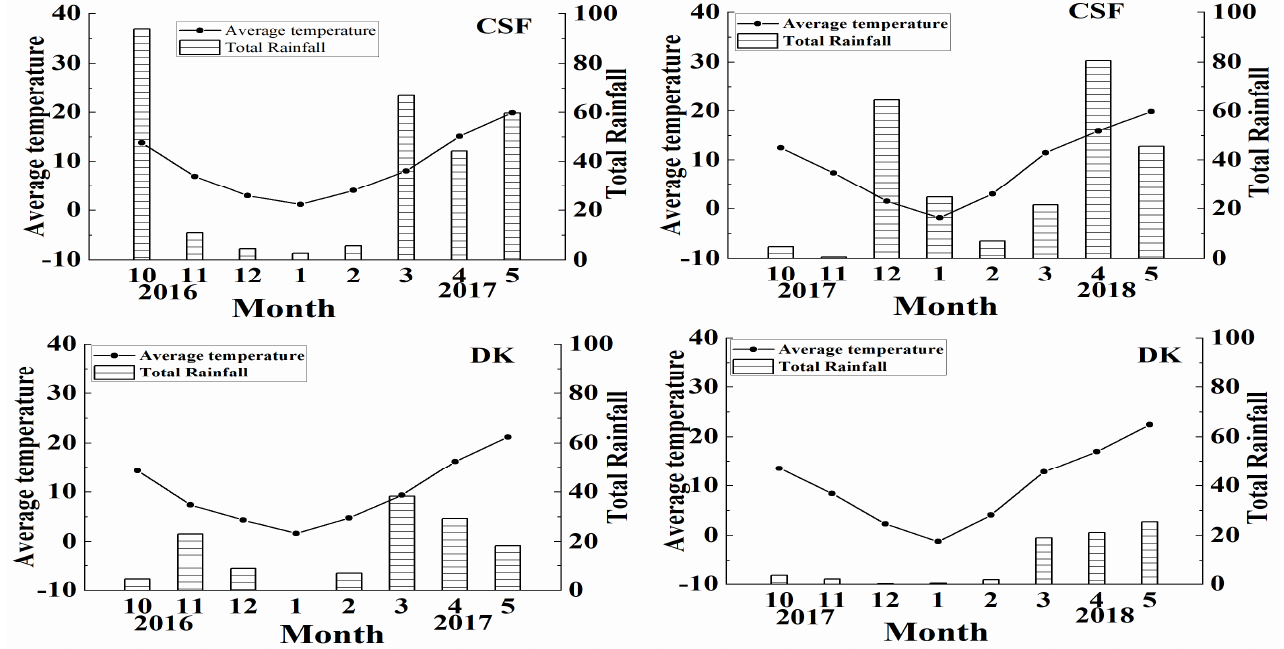
Figure 1. Precipitation and temperature changes in the winter wheat growth season from 2016 to 2018. CSF: Crop specimen farm; DK: Doukou wheat and maize test station.